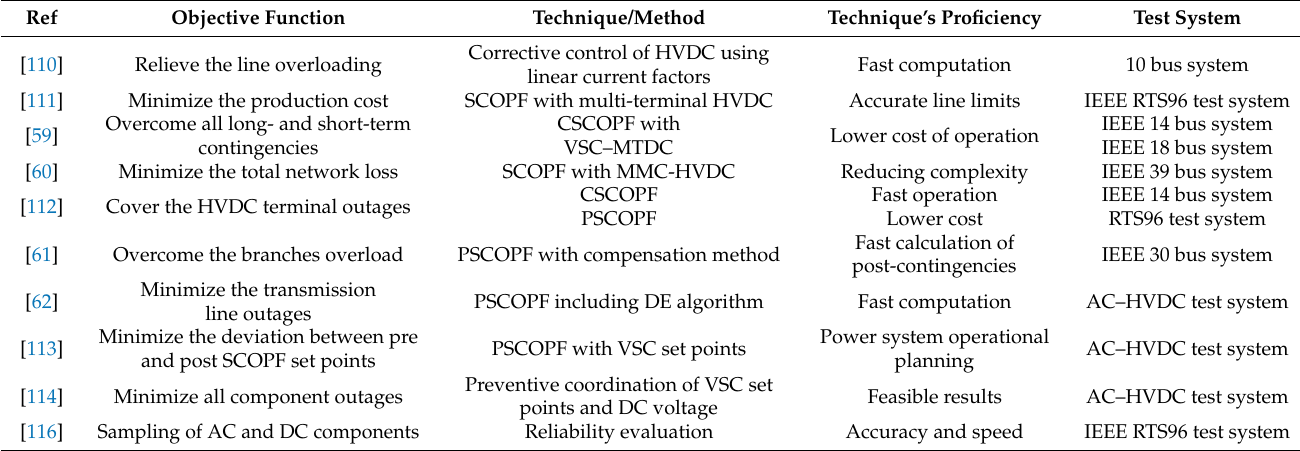
Table 6. Summary of the techniques used to overcome the security challenges of hybrid HVAC–HVDC grids.